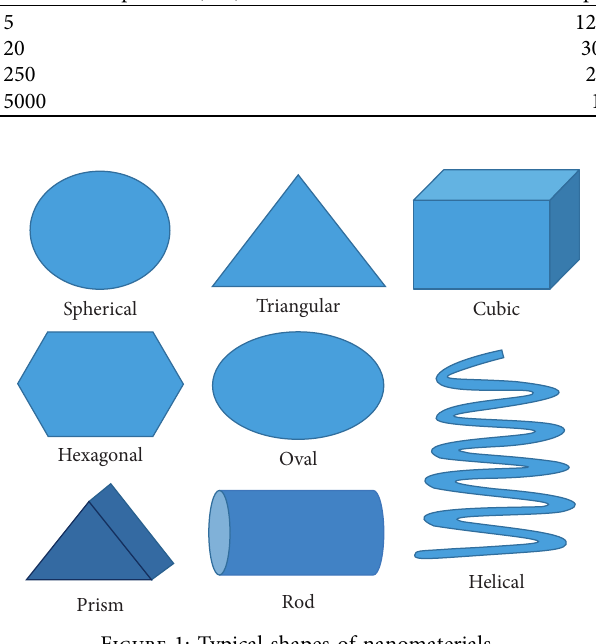
Figure 1: Typical shapes of